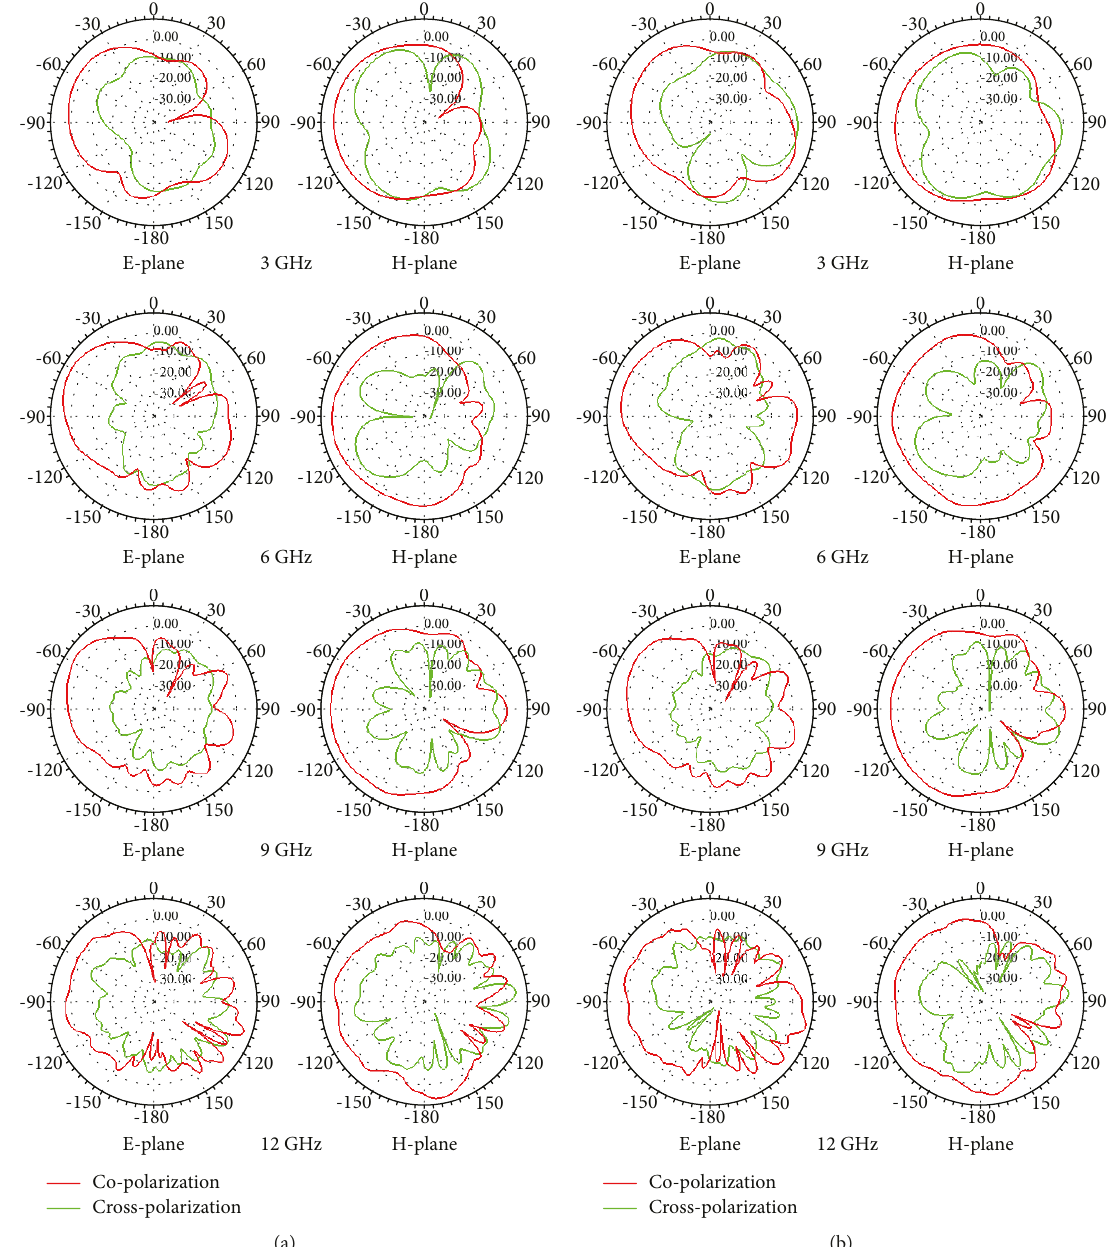
Figure 5: Simulated far- fi eld E-plane and H-plane radiation patterns at several elected frequencies for (a) original and (b) low-pro fi le wideband log-period monopole end- fi re